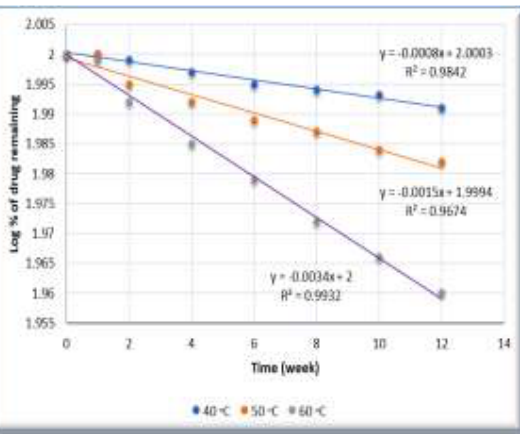
Figure 14. SEM of lyophilized selected F13 Stability study of the selected F13 lyophilized powder